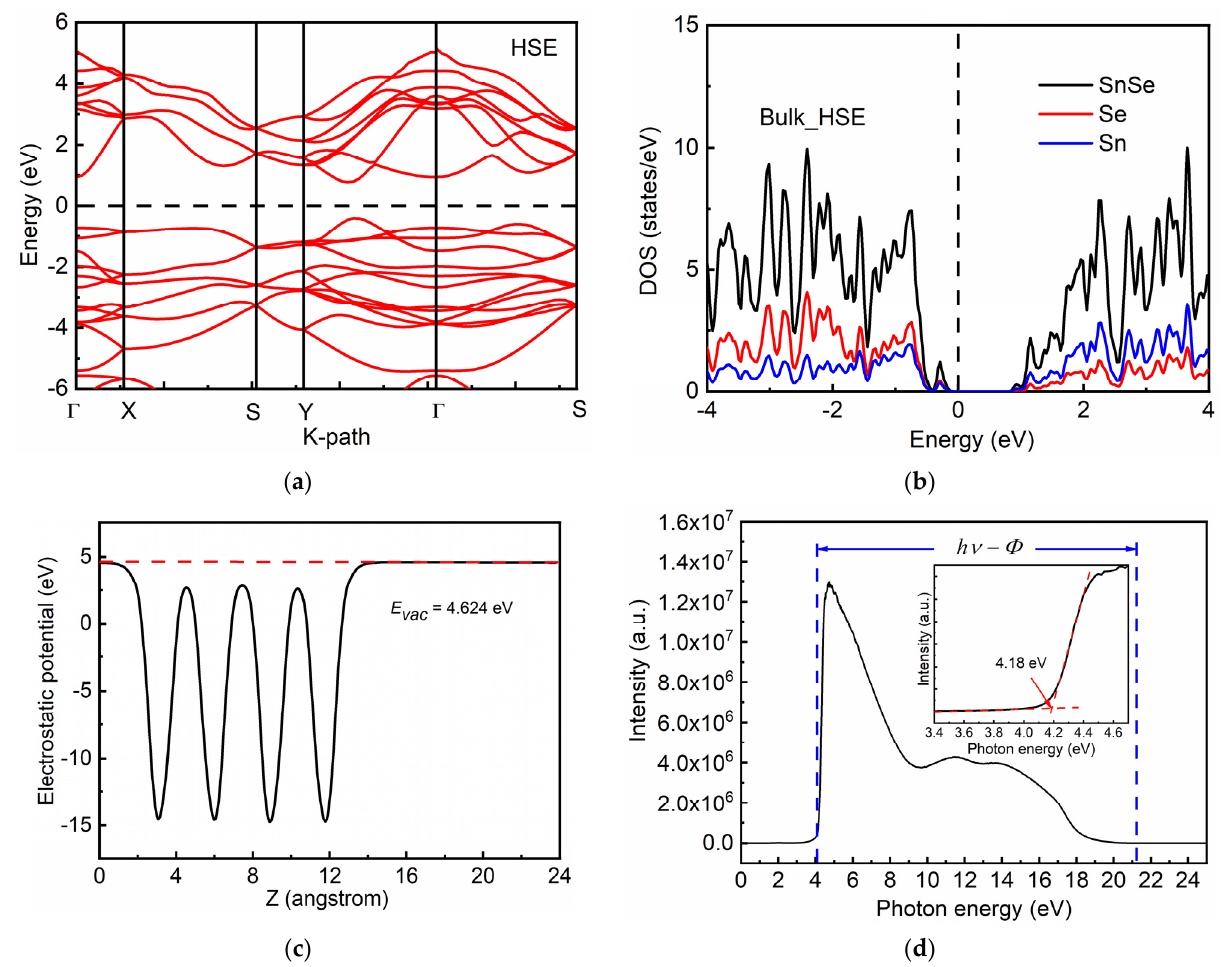
Figure 4 . Energy diagrams of SnSe. ( a ) Energy bands in the HSE functional calculations. ( b ) DOS in the HSE functional calculations. ( c ) Average electrostatic potential of the SnSe (001) surface. The red dashed line shows the energy at the vacuum level. ( d ) Work function of SnSe measured by UPS.